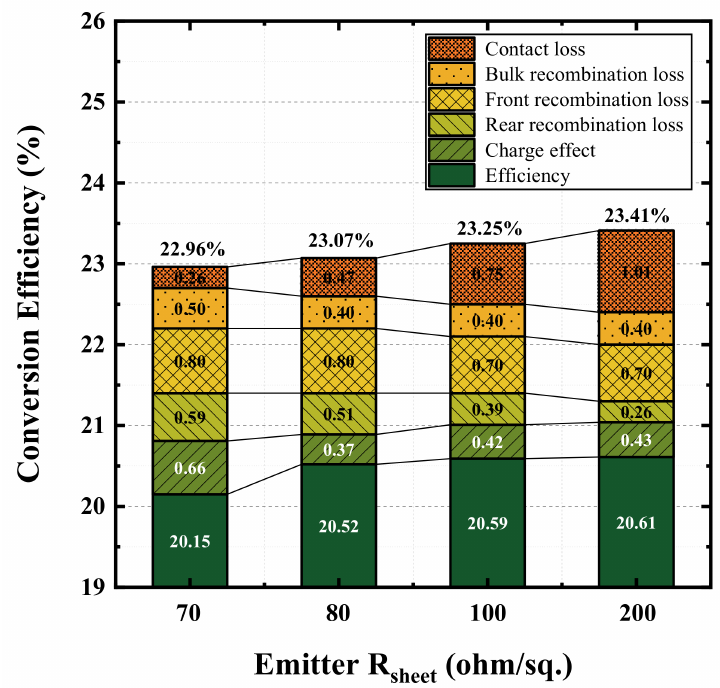
Figure 6. Loss analysis using TCAD simulation to achieve conversion e ffi ciency over 23% with respect to the optimized R sheet